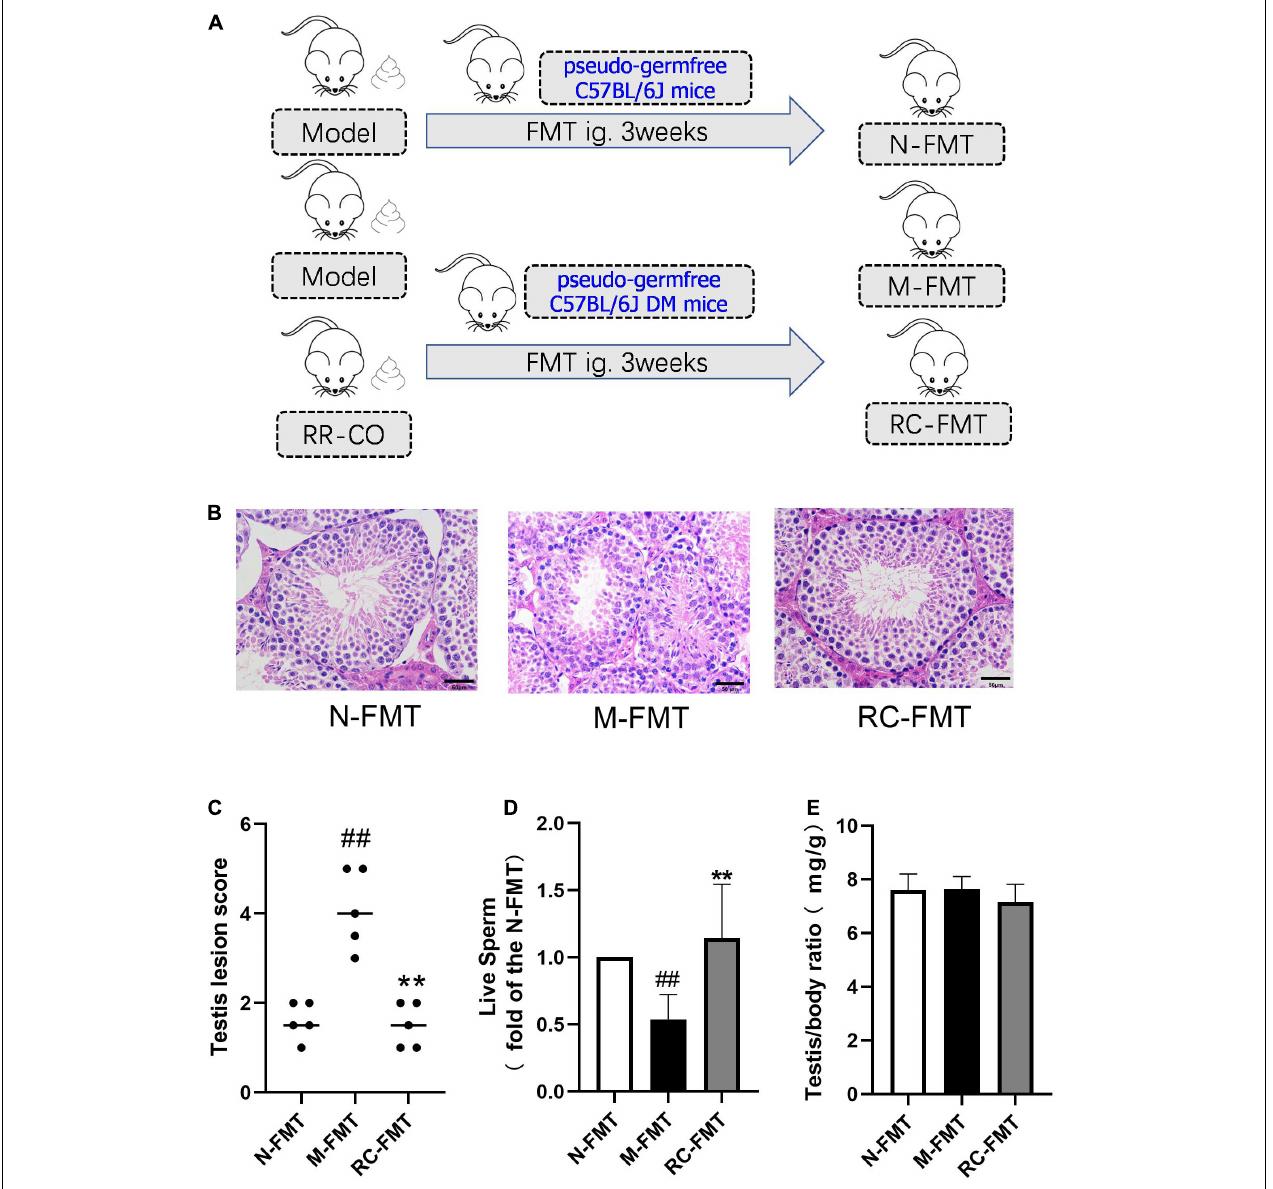
FIGURE 5 | The effects of FMT on DM-induced testicular damage. (A) Flow chart of FMT animal study. (B) H&E staining of mice testicular tissues. Scale bar, 50 µ m. (C) A chart showing testicular lesion scores. (D) A chart showing the live sperm rate (a fold of the N-FMT). (E) Testis/body weight ratio. Data are expressed as mean ± SD. ## P < 0.01 vs. N-FMT; ** P < 0.01 vs. M-FMT; n =